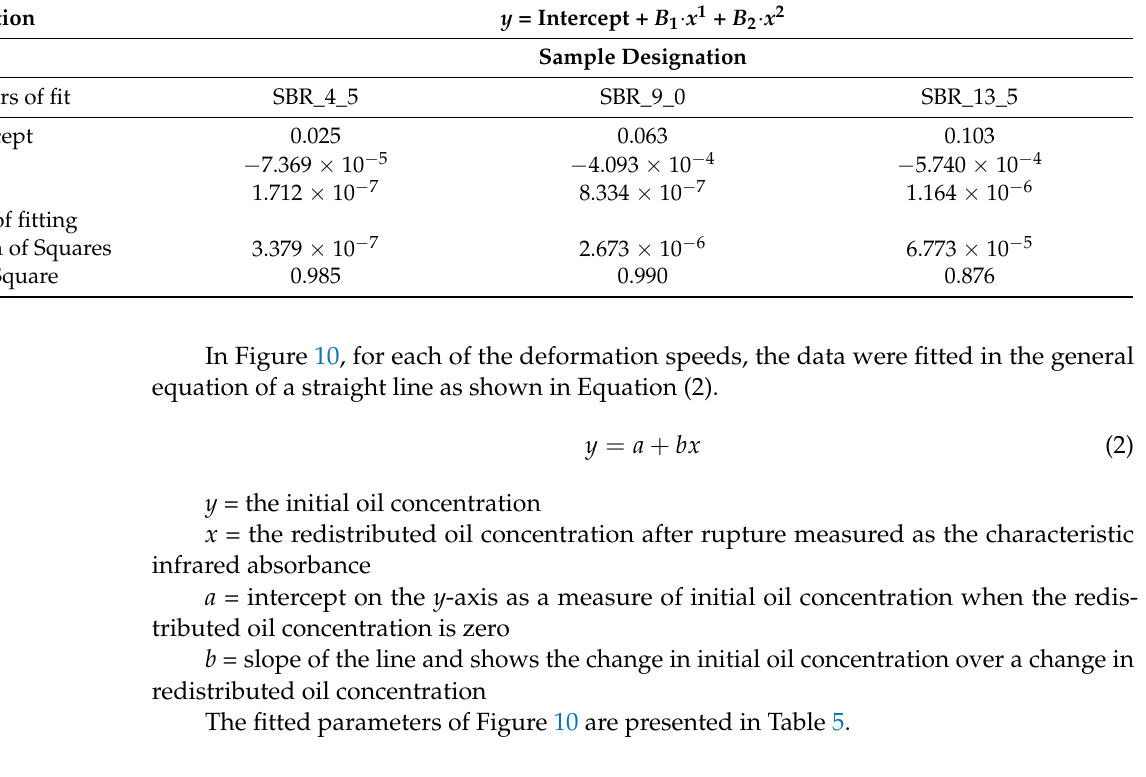
Figure 10. Initial oil concentration against redistributed oil concentration after rupture for various deformation speeds (the numbers in the legend represents the deformation speed in mm · min − 1 ). Table 4. Parameters for the parametric fitting of curves in Figure